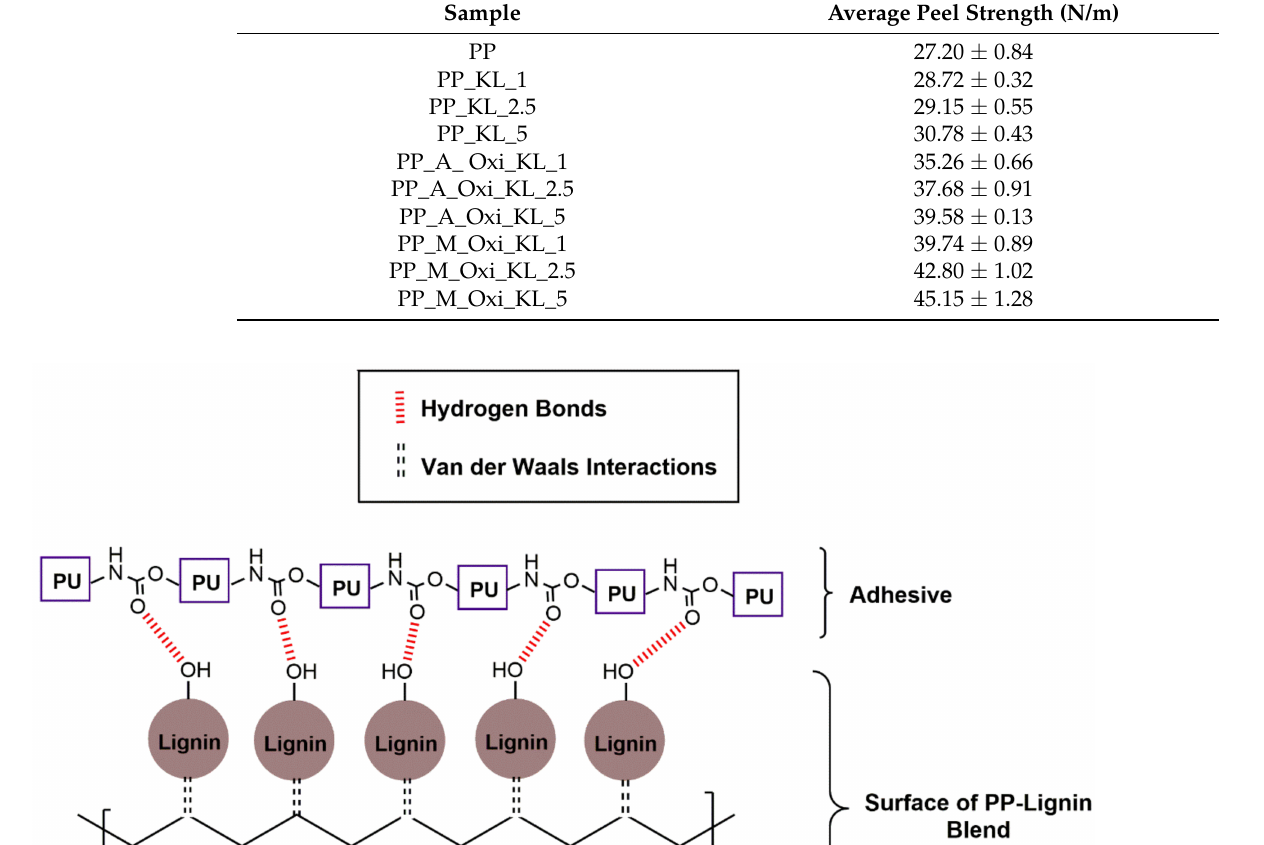
Table 5. Average peel strength of BOPP/PP and BOPP/PP-Lignin adhesively bonded joints.